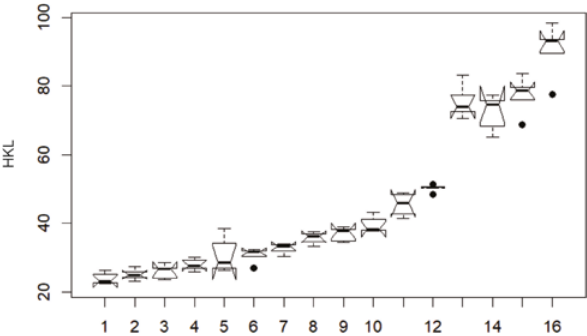
Fig. 2. Boxplots illustrating the continuous variability of HKL (Haploid Karyotype Length), as inferred from de Kruskal Wallis analysis. The numbers on the x axis represent the species ordered by crescent HKL values (in µm): S. sanctae-catharinae (1), S. adspersum (2), S. flaccidum (3), S. scuticum (4), S. pseudocapsicum (5), S. concinnum (6), S. variabile (7) S. acerifoium (8) S. palinacan- thum (9) S. inodorum (10), A. arborescens (11) B. uniflora (12) C. mariquitense (13) S. diploconos (14) C. laevigatum (15) P. pubescens (16). The central box represents 50% of the data from de upper to lower quartile. The horizontal bar expresses the median position. The extremity of the vertical lines indicates minimum and maxi- mum values of HKL, if they are no outliners. When outliners are present, they are represented by